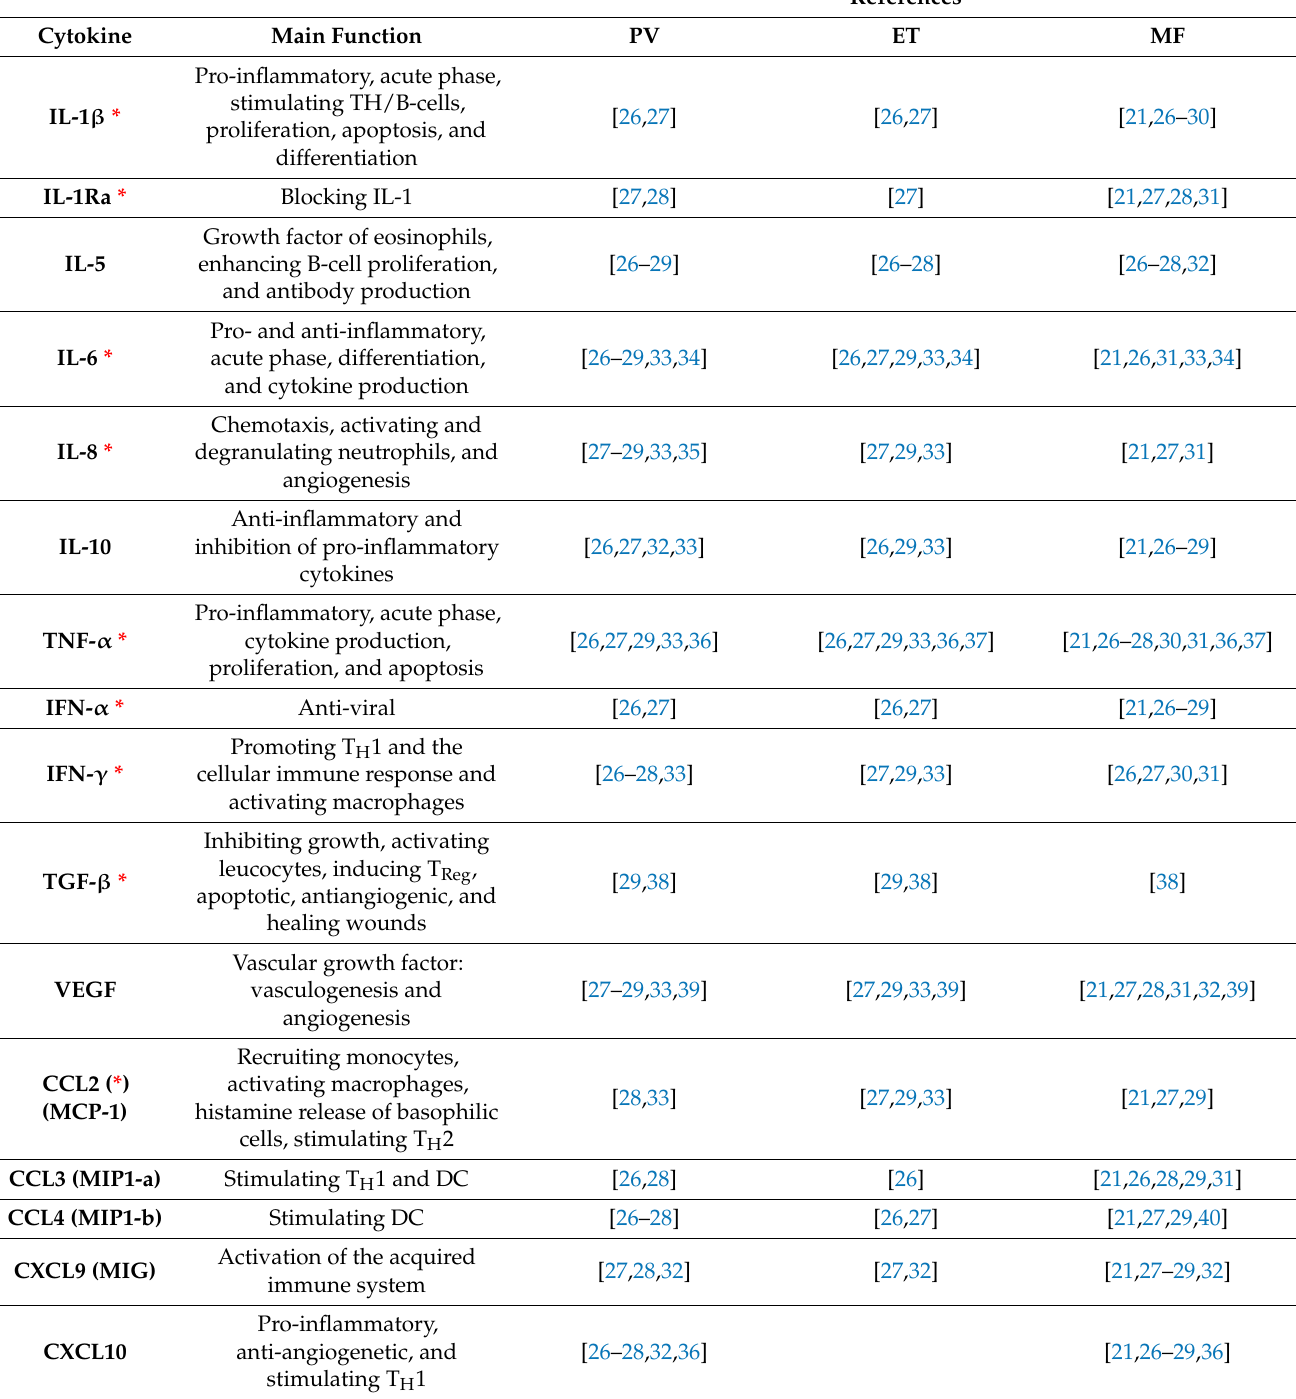
Table 1. Up-regulation of inflammatory cytokines in MPN (inspired by